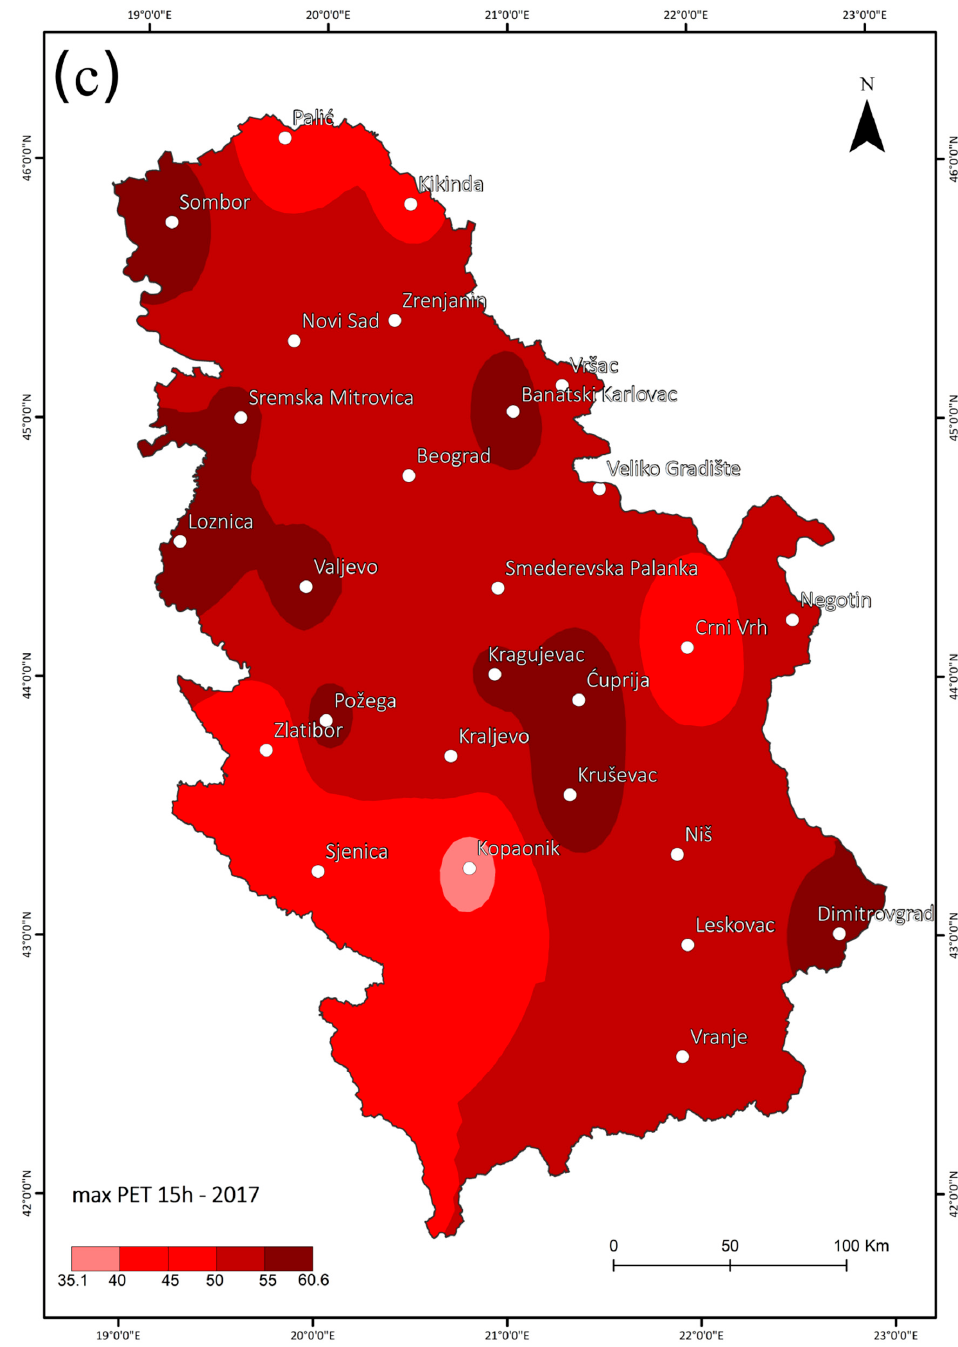
Figure 1. The highest PET values and the extension of the heatwave on the territory of Serbia. ( a ) Diurnal PET values recorded at Smederevska Palanka meteorological station (2007 heatwave is shown as highlighted part). ( b ) Maximum PET values during the heatwave at Smederevska Palanka meteorological station; the gray line shows 95th percentile threshold based on the 1981–2010 reference period. ( c ) Spatial distribution of maximum PET values recorded at 15.00 at all meteorological stations in Serbia [95].